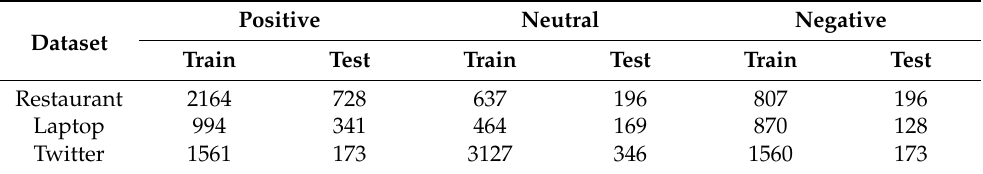
Table 1. Detailed statistical of the three experimental